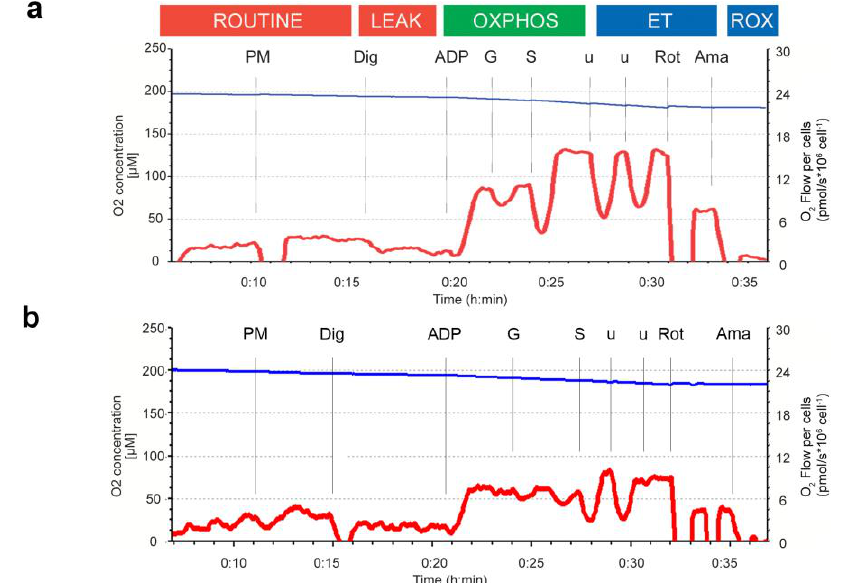
Figure 1. ( a , b ) Representative respirometry traces following high-resolution respirometry protocol applied to permeabilized PBMCs obtained from CTRL ( a ) and T2D ( b ) samples. Blue line: O 2 concentration over time; Red line: cell-specific O 2 flow (JO 2 ), calculated as the negative time derivative of O 2 concentration, corrected for instrumental back- ground, and expressed as pmol/s*10 6 cells -1 . For titration steps and SUIT protocol, see the